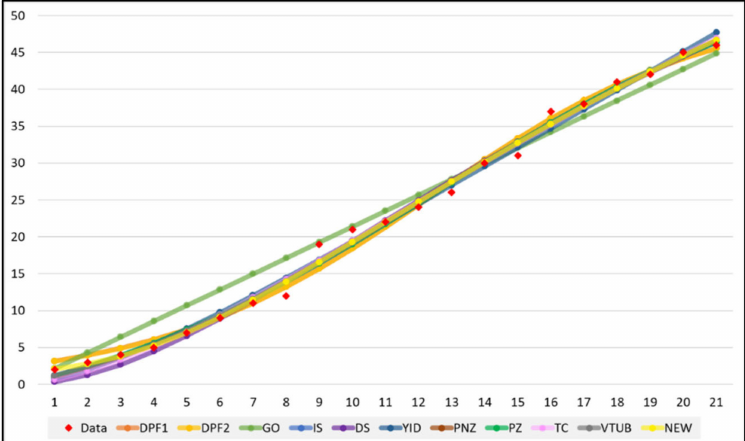
Figure 5. Mean value function of the models for dataset 1.